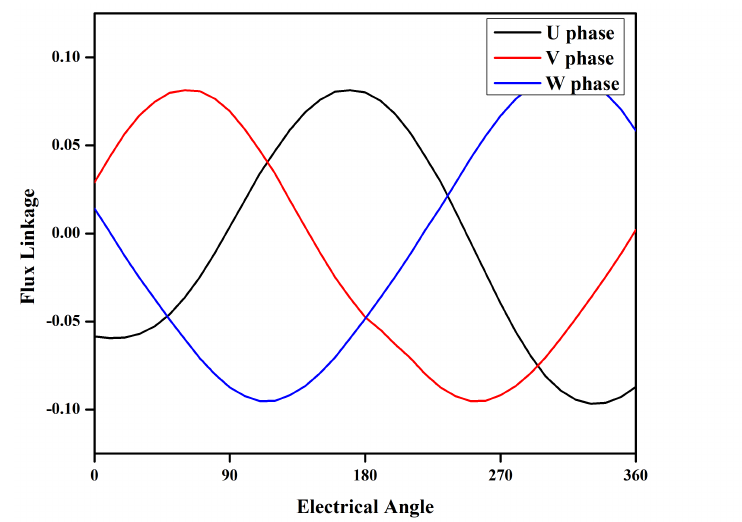
Figure 11. No-load flux